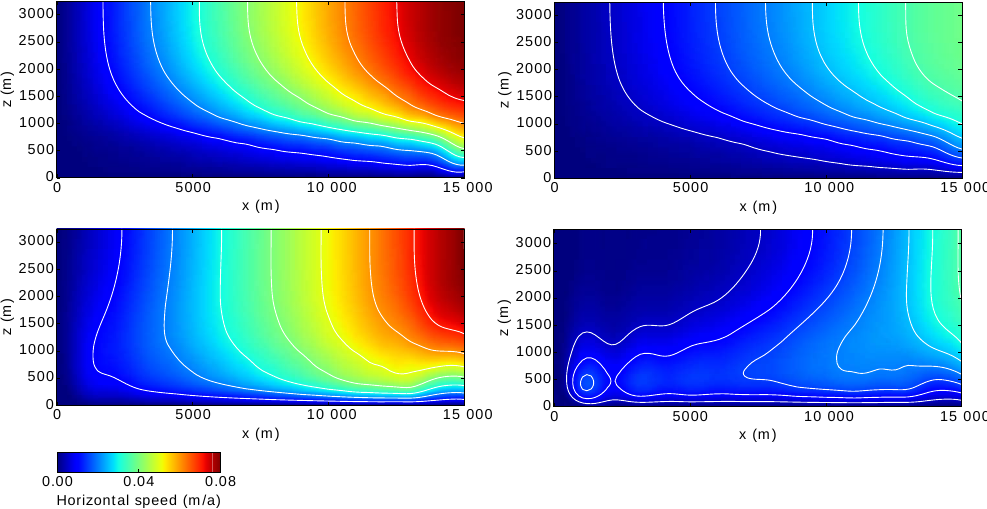
Figure 7. Horizontal velocity field (ma − 1 ), for the non-isothermal case and α = 3. Top: 3-D model. Bottom: 2.5-D model, with a scanning window of 10km. Left: α = 3, white contour lines spaced by 0.01ma − 1 . Right: α = 6, white contour lines spaced by 0.005ma − 1 .